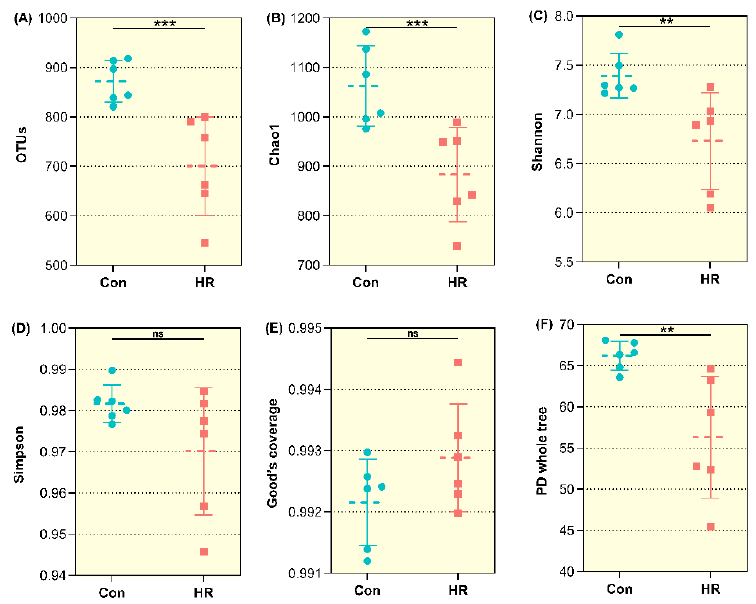
Figure 4. Alpha diversity indices of the colonic bacterial communities in growing goats. Con, control diet; HR, high-rice diet. ( A ) The operational taxonomic units (OTUs) between the two groups in the colon of goat. ( B ) The bacterial richness in the colon estimated by the Chao 1 value. ( C , D ) The bacterial diversity in the colon estimated by the Shannon and Simpson index. ( E ) The sequencing depth between the two groups in the colon of goat. ( F ) The bacterial diversity in the colon estimated by the PD whole tree. “ns” means there is no difference between the two groups ( p > 0.1), “**” means that the difference between the two groups is significant ( p < 0.05), and “***” means that the difference between the two groups is extremely different ( p < 0.01).